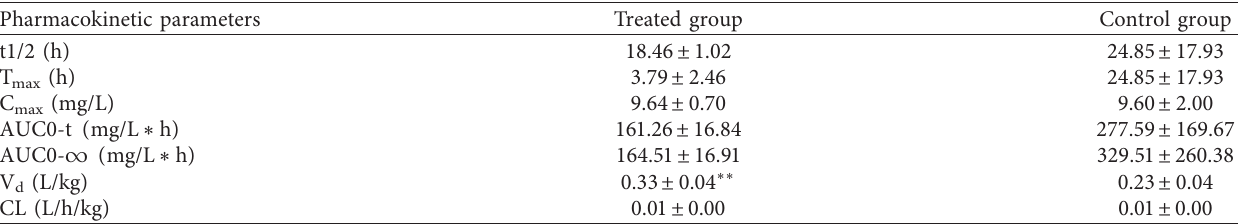
Figure 5: Plasma concentration–time curves of warfarin in treated group and control group. Six rats in each group were intragastrically given 20mg/kg of LDR (treated group) or identical volume of 0.5% CMC-Na (control group) for fifteen consecutive days, respectively. The two groups were intragastrically given warfarin prepared in 0.5% CMC-Na at a dose of 2mg/kg at the sixteenth day. Table 8: Pharmacokinetic parameters of warfarin in the treated group and control